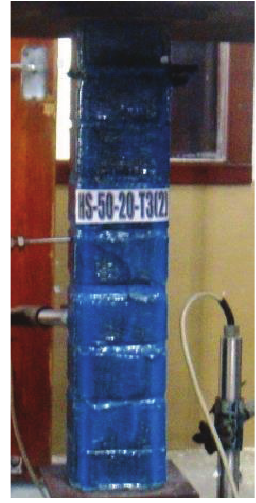
Figure 7: Failure mode of column HS-50-20-T3 (2)